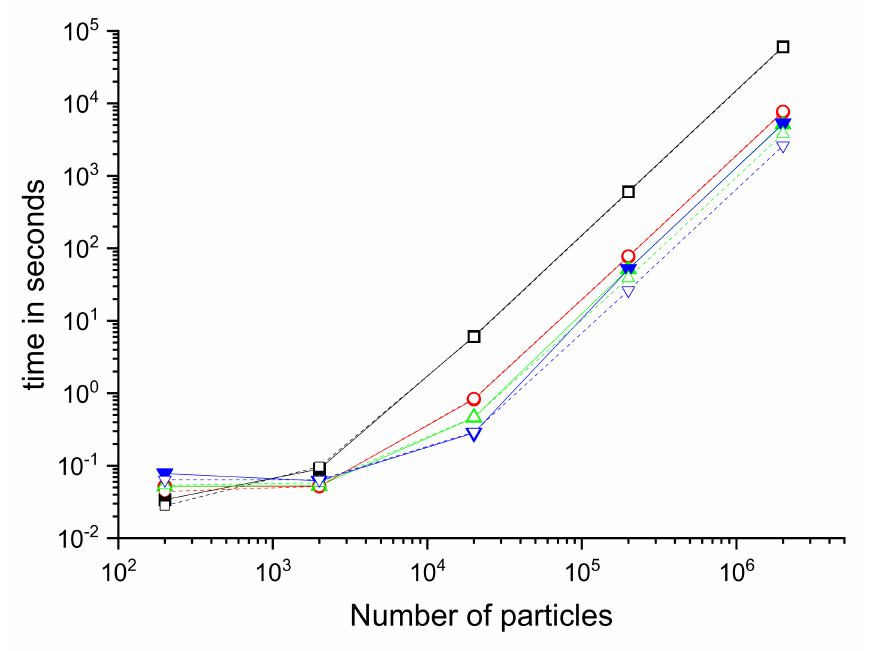
Figure 4. Comparison of execution times for kernels with different unroll factors (UF = 1 black squares, UF = 8 red Circles, UF = 16 green up triangles, UF = 32 blue down triangles) and different transmission format (full lines and symbols float 32 bit and dashed lines and empty symbols unsigned short 16 bit).